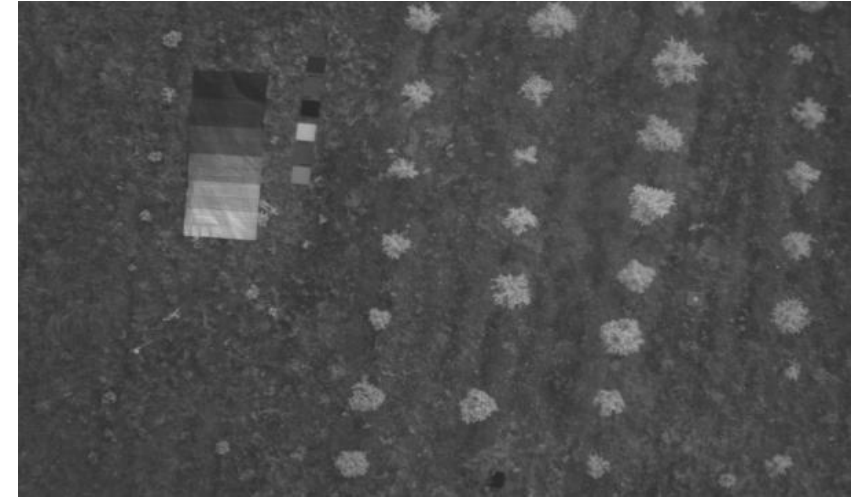
The selected radiance control surfaces were obtained from the spectroradiometer.